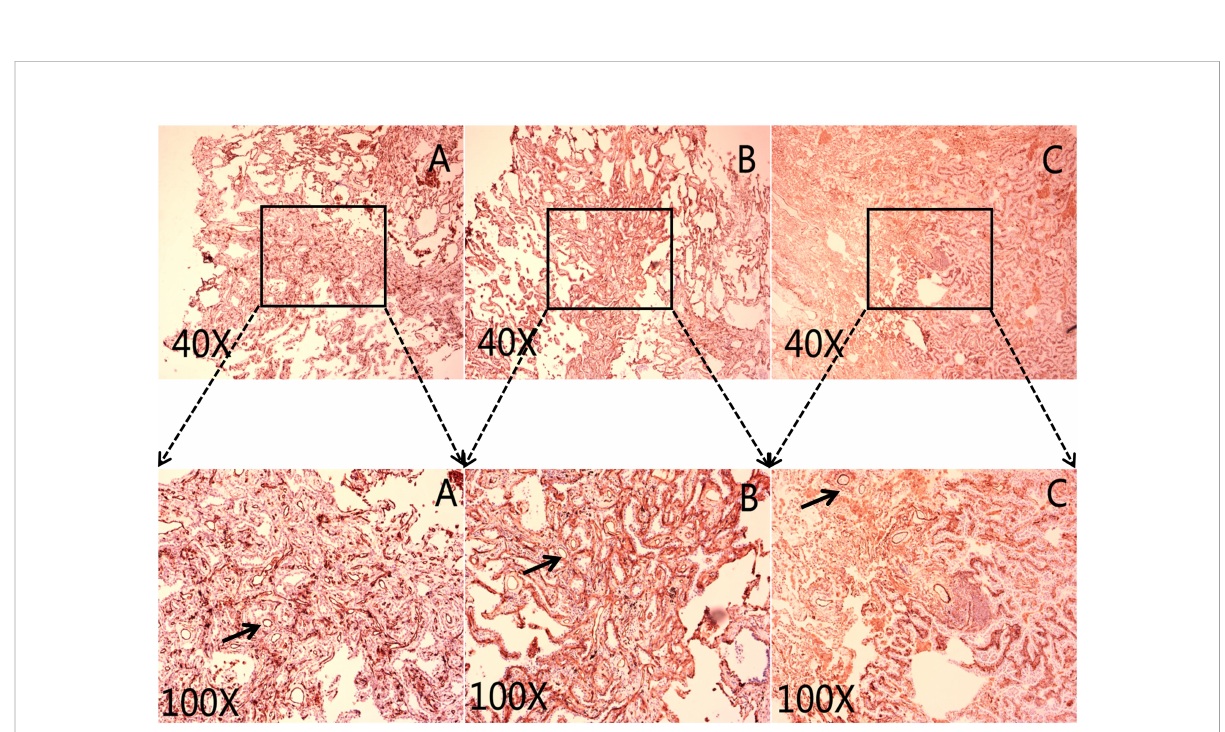
FIGURE 3 Representative micrograph in lung cancer tissues. The black arrows mark the microvascular endothelial cells. (A) Representative micrograph of CD31 expression in carcinoma of the lungs tissues. (B) Representative micrograph of CD34 expression in carcinoma of the lungs tissues. (C) Representative micrograph of CD105 expression in carcinoma of the lungs tissues. Black arrows point to the clearly stained